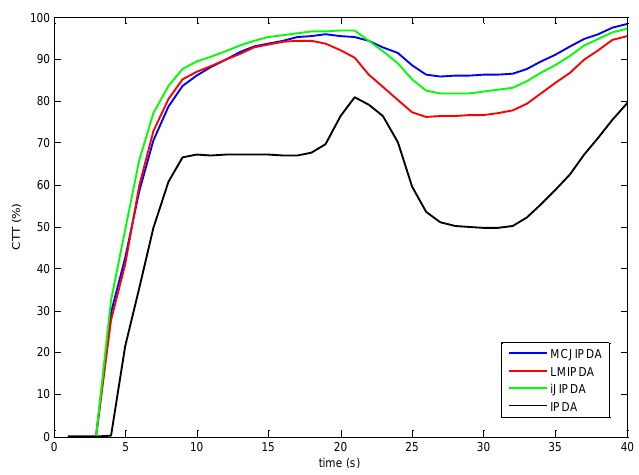
Figure 6. The confirmed true tracks rate for Case #1.